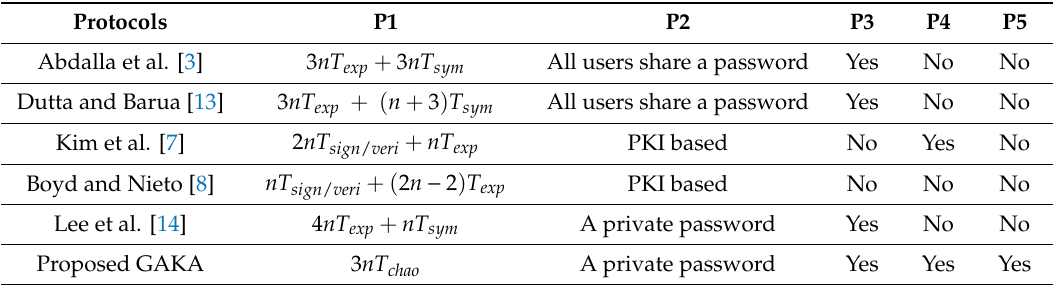
Table 2. Comparisons of other related protocols and the proposed